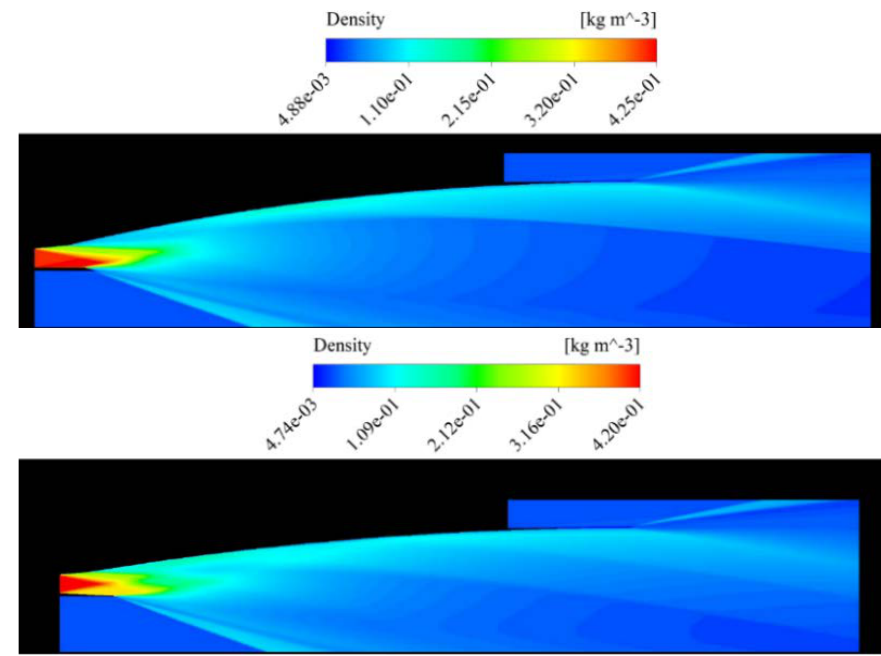
Figure 16. Density contours of DP102 ( top ) and DP456 ( bottom ) illustrating shock structures.